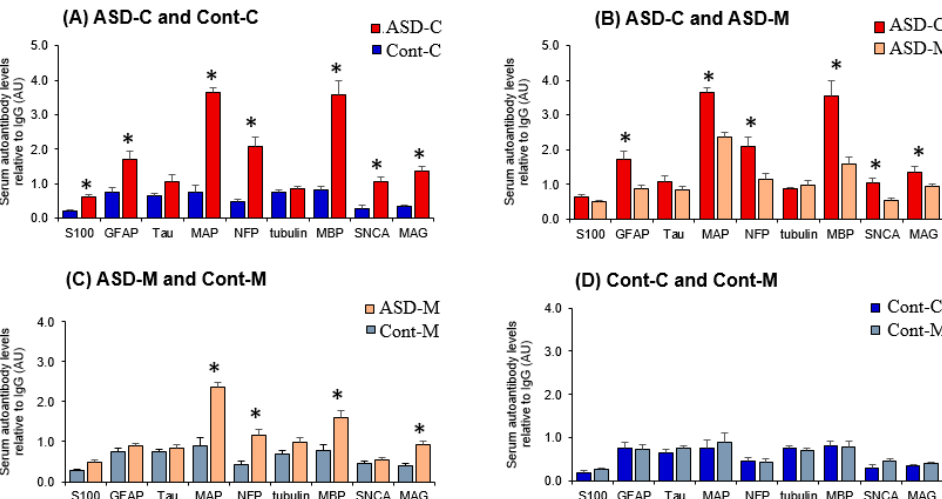
Figure 3. Histogram representing the mean levels of autoantibodies against neural proteins relative to total IgG with the bar indicating standard error. Comparison between ( A ) control children (Cont-C) and ASD children (ASD-C); ( B ) ASD Children (ASD-C) and ASD children’s mothers (ASD-M); ( C ) ASD children’s mother (ASD-M); ( D ) control children (Cont-C) and control children’s mothers (Cont-M). Significant differences with P < 0.05 are indicated in asterisks and the actual p-values are presented in Table 3. Table 3. Autoantibodies against neuronal proteins in the sera of children with autism (ASD-C), healthy children (Cont-C), mothers of ASD children (ASD-M) and mothers of healthy children (Cont- M).